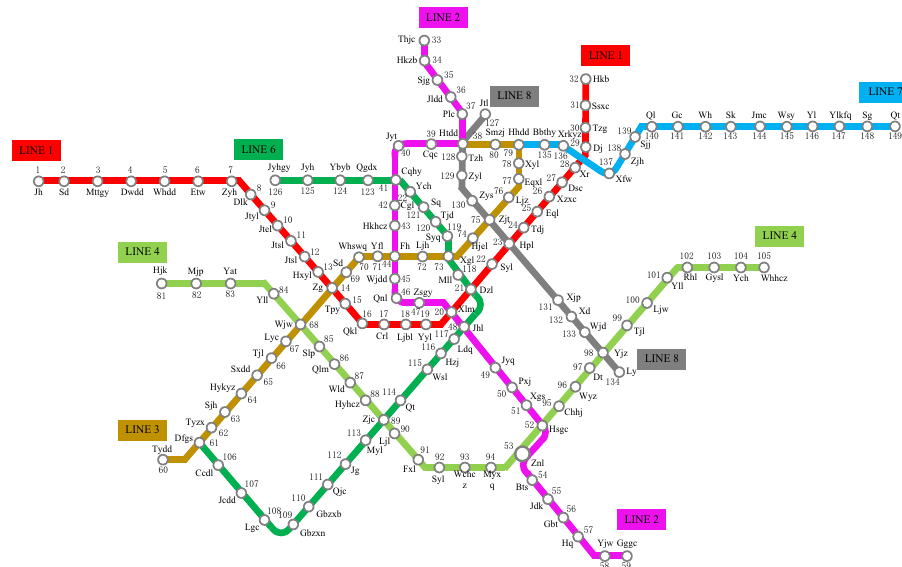
Fig. 1 Wuhan’s subway